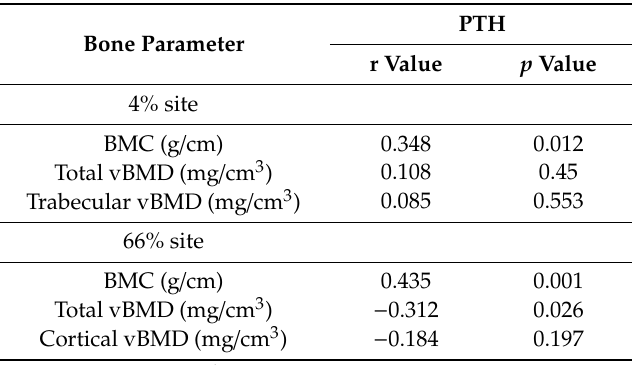
Table 8. Associations between PTH concentrations and radial bone densitometry assessed by pQCT of Brazilian women living in England ( n = 51) 1 .